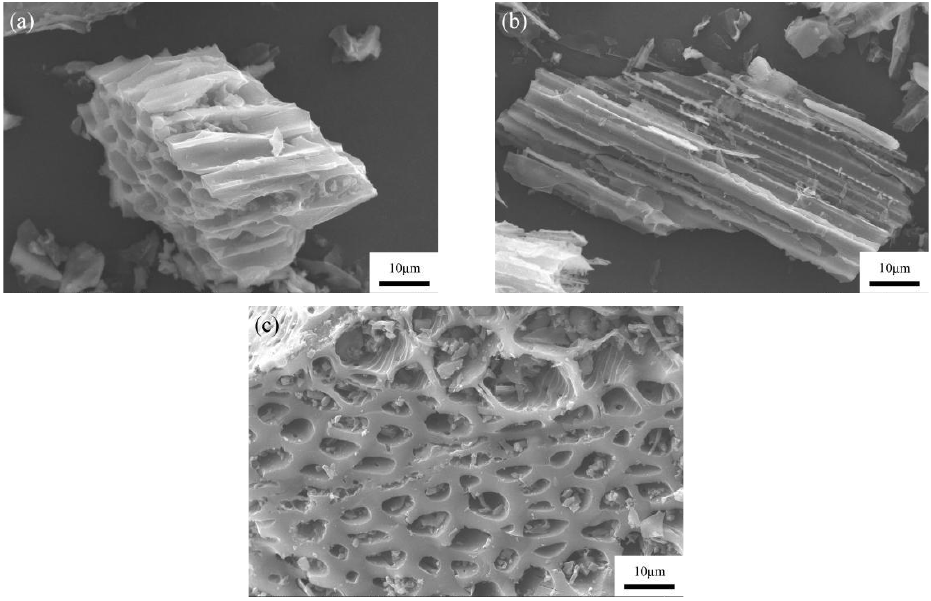
Figure 1. The SEM images of ( a ) QBB, ( b ) SBB, and ( c ) GBB at preparation temperature T = 650 °C.